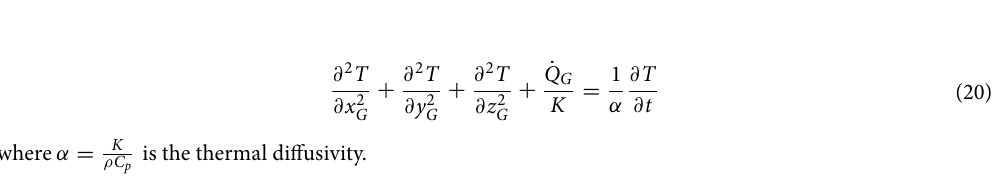
Figure 3. Diffusion of carbon atoms into the surface of grey cast iron at 900° for 90